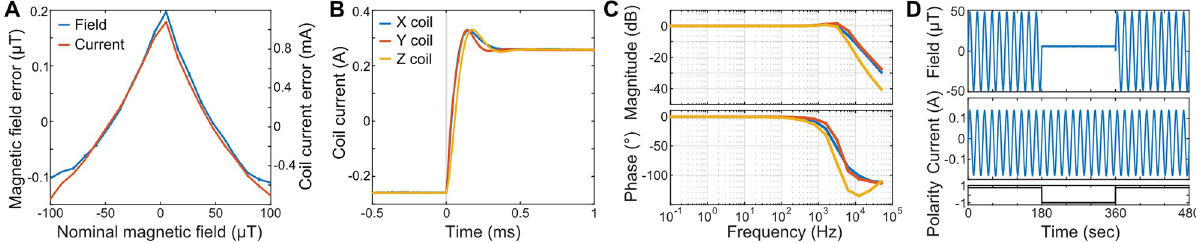
Fig 3. Coil amplifier. A: Coil amplifiers show an approximately linear response over a large range. Magnetic field strength and coil current were measured for a control voltage sweep corresponding to a magnetic field strength of approx -100 μ T to 100 μ T. Residuals of a linear fit of magnetic field and coil current are shown. Average of 3 repeats, error bars: ± SD. B: Coil current responses to a control voltage step for the three coils corresponding to a transition from -100 to 100 μ T. Frequency compensation was adjusted for maximal speed of the transition and minimal overshot. C: Bode plots of amplitude attenuation (top) and phase shift (bottom) of the coil current for sinusoidal control voltages from 0.1 Hz to 50 kHz at ± earth magnetic field strength. D: Field blanking. By switching the coil wiring from serial to anti-serial (bottom) the magnetic field produced by the coils is canceled out (top) though the coils are still under current (middle). Note that the offset corresponds to the remaining natural magnetic